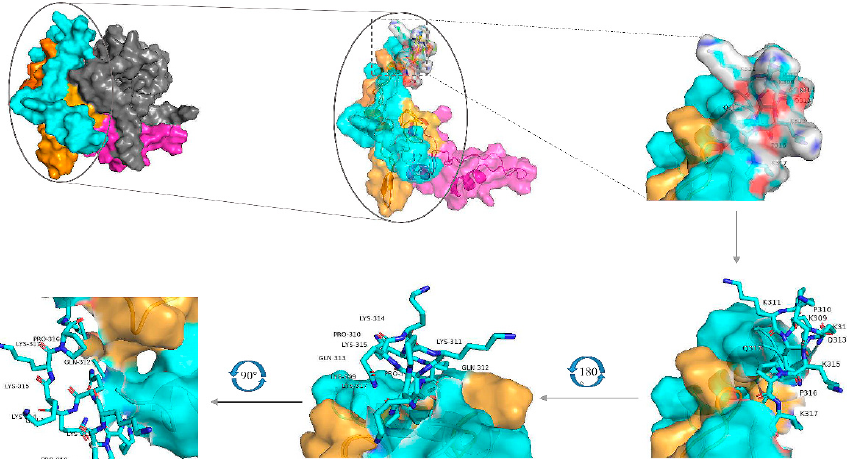
Figure 7. Model of the I-TASSER predicted 3D structure of the N-protein, visualized using the PyMOL molecular graphics and modeling system. The overall structure is shown on the upper left, the yellow areas represent aa231-291, blue areas represent aa292-342, grey areas represent aa1-171, and pink areas represent aa172-230. The EP-4E88 residues (aa 309-KPKQQKKPK-317) are shown as a stick figure and are displayed at di ff erent angles of